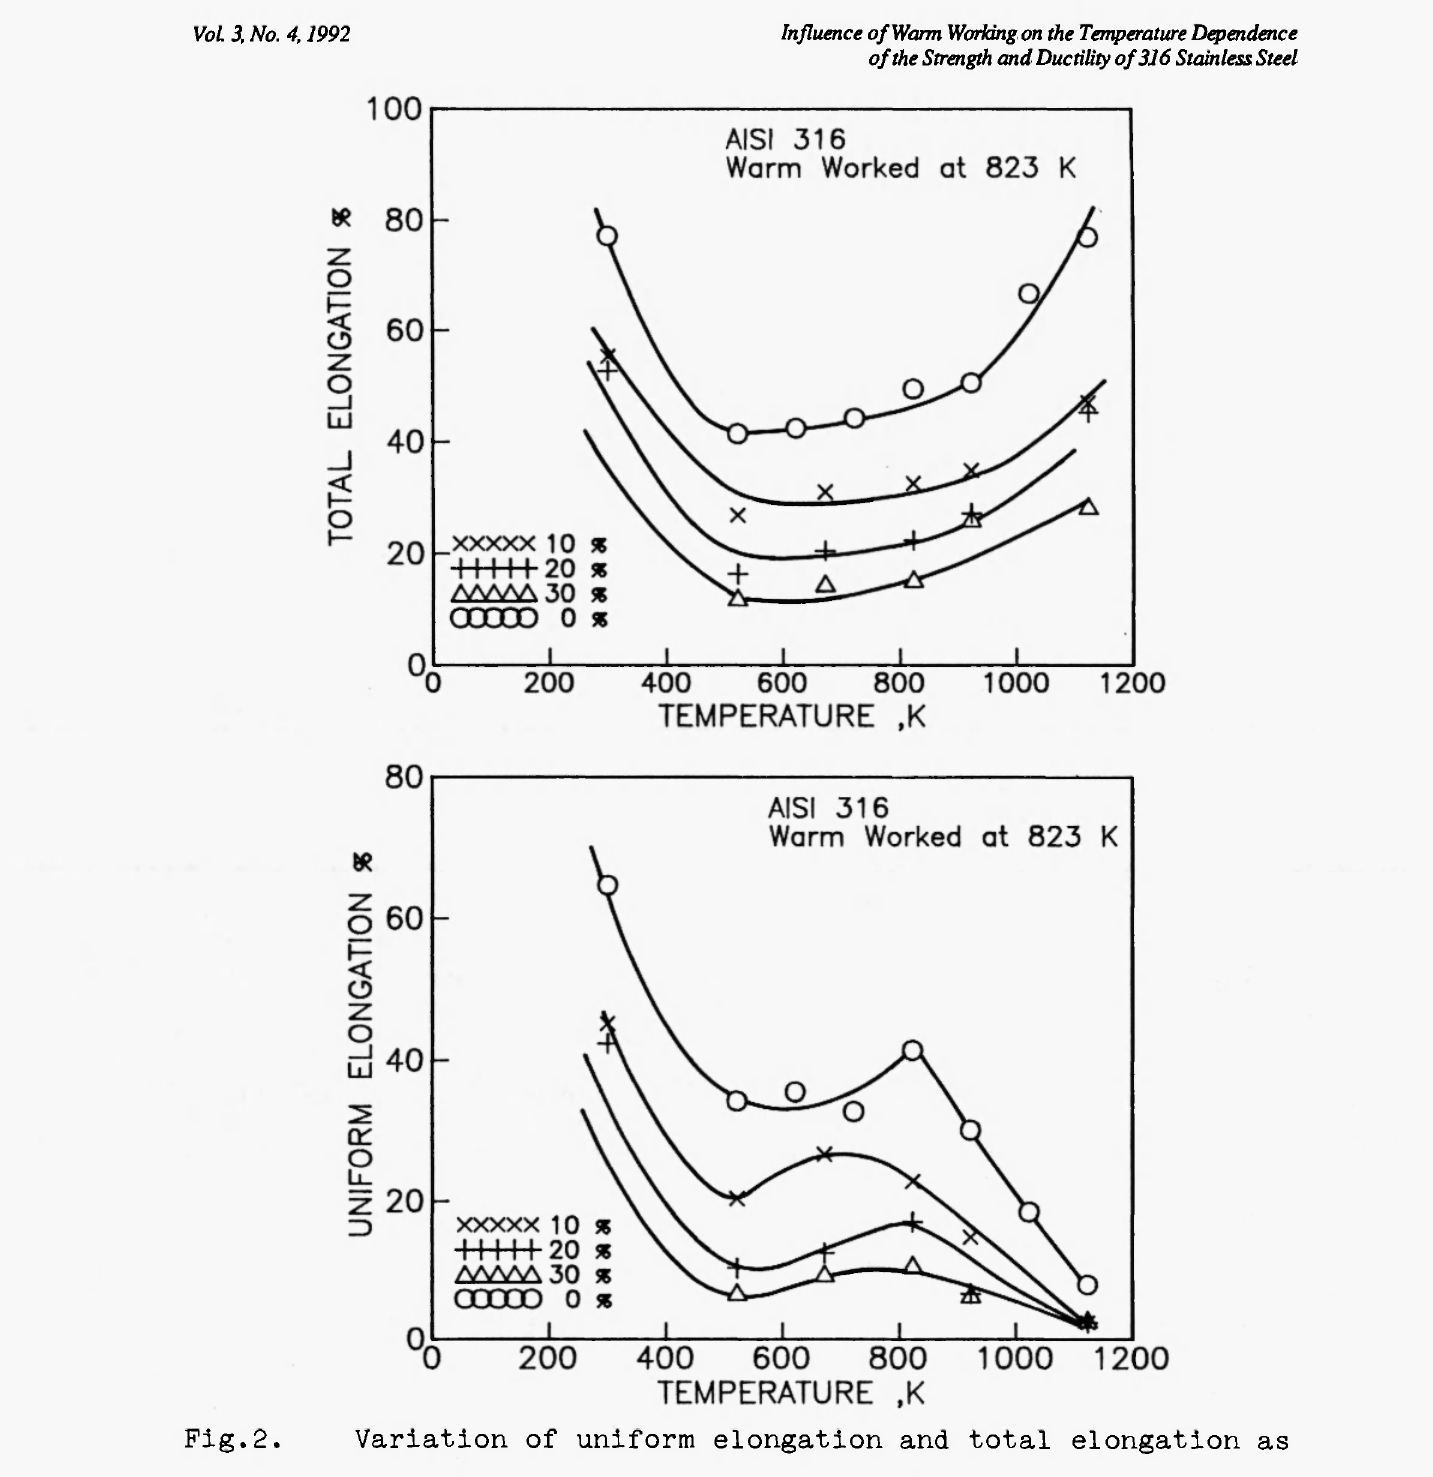
Fig.2. Variation of uniform elongation and total elongation as a function of test temperature for various amount of warm working at (a) 823 K, (b) 923 K, (c) 1023 Κ and (d) 1123